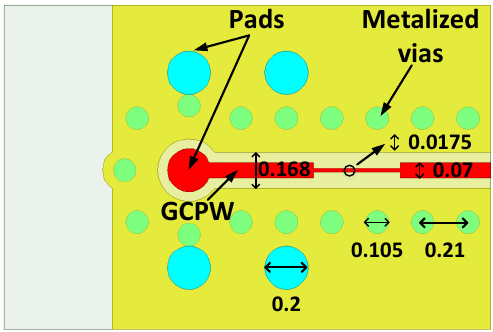
Figure 4. Top view of the ceramic substrate for the transition (Units: mm).